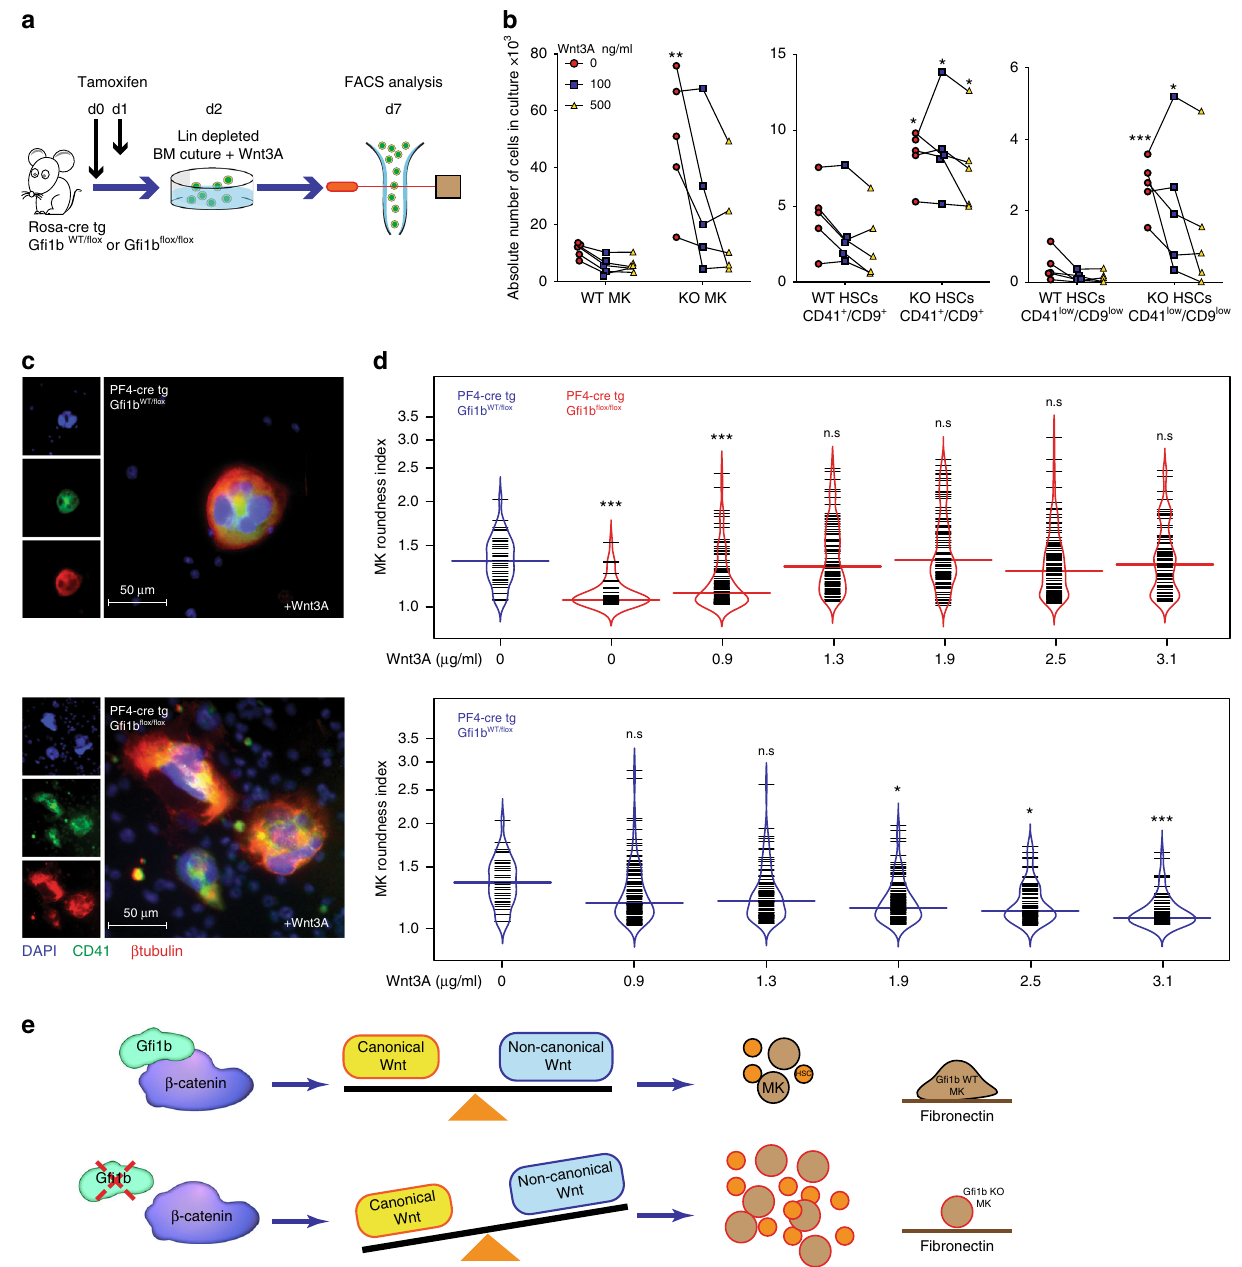
Fig. 9 Up-regulation of canonical Wnt signaling rescues G fi 1b-de fi cient phenotypes in HSCs and MKs. a , b Lineage depleted G fi 1b WT/KO BM cells were taken into culture under the indicated concentrations of Wnt3A. MKs and HSCs CD41 low /CD9 low were quanti fi ed by FACS at day seven post Tamoxifen injection, n = 5 GFI1b WT and fi ve GFI1B KO mice. c G fi 1b KO MKs spreading on fi bronectin-coated matrices is rescued by Wnt3A treatment. d MK roundness index plotted as bean plot. Upper part: spreading of G fi 1b KO MKs on Fibronectin coated matrices is rescued by Wnt3A treatment at increasing concentrations. Lower part: spreading of WT MKs on Fibronectin coated matrices is abrogated by Wnt3A treatment at increasing concentrations. (* p < 0.05, ** p < 0.001, *** p < 0.0001 on a Mann – Whitney U-test, colored horizontal line shows median, n values for upper part are, in order from left to right: 39, 46, 95, 83, 91, 111, and 87. n values for lower part are, in order from left to right: 39, 120, 89, 108, 86, and 81). Each horizontal short line represents one individual cell. e Proposed model: G fi 1b interacts with β -catenin and regulates Wnt signaling in HSCs and MKs. Deletion of G fi 1b alters the balance between canonical and non-canonical Wnt signaling leading to expansion of HSCs and MKs and impaired MKs spreading on Fibronectin coated